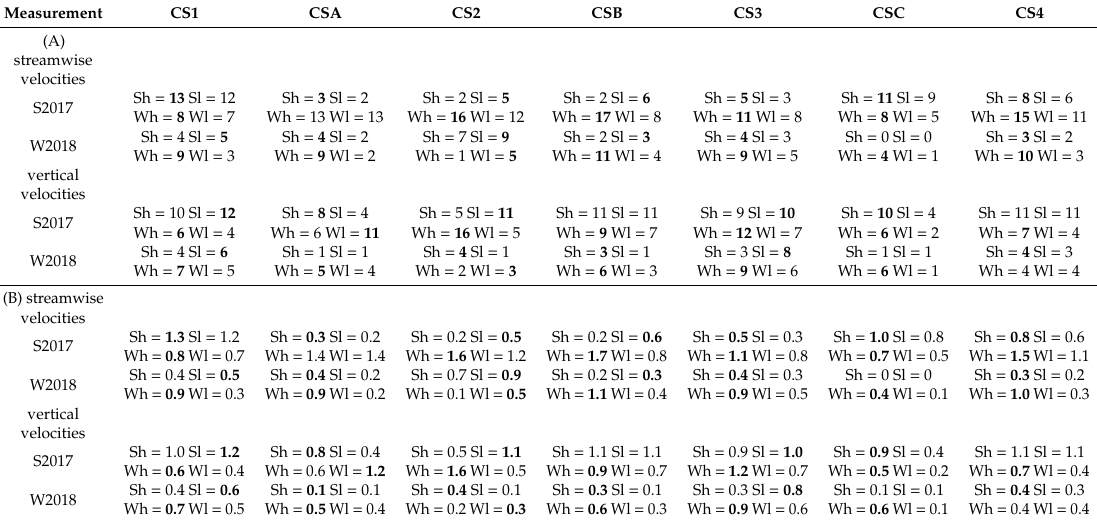
Table 7. ( A ) The occurrence numbers and the type of macroturbulent wedges observed based on the LISA analysis at all measurement locations from W2018 and S2017 time steps. ( B ) The occurrence numbers are related to the length of the measurements (i.e., occurrence per minute). Both streamwise and vertical velocities were analyzed from these time steps. See the marked dots of statistically significant flow wedges from Figures 3–8 and Figures S11 and S12. Sh = strong high flow wedges, Sl = strong low flow wedges, Wh = weak high flow wedges, Wl = weak low flow wedges. It is bolded, whether the high or low flow clusters are more than the other. The measurement length was circa 600 s (10 min) during both S2017 and